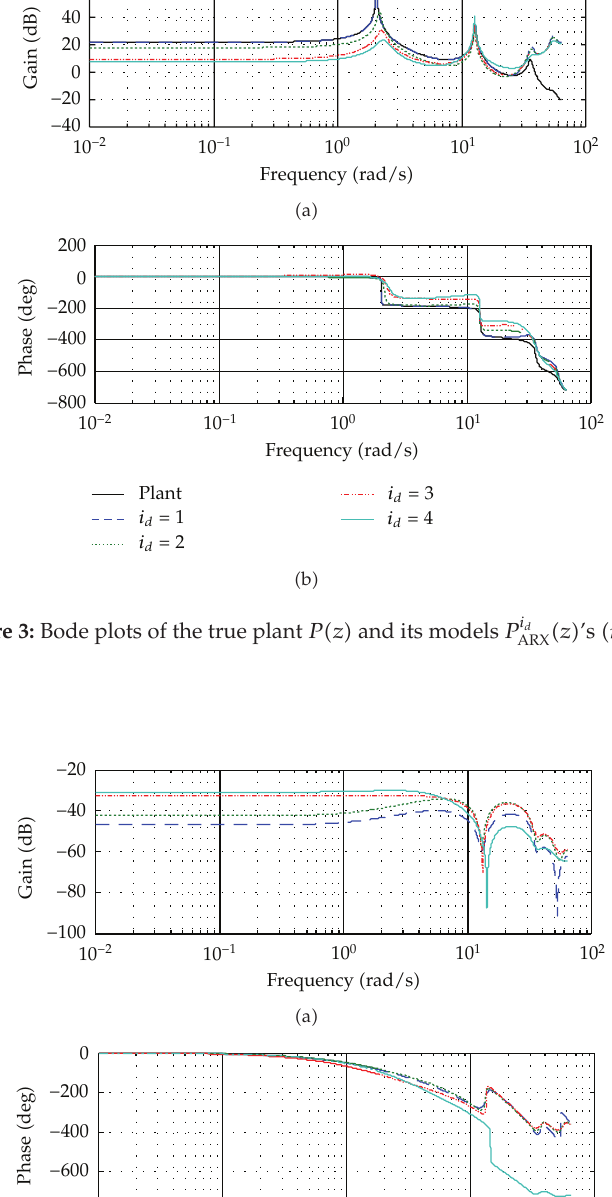
Figure 4: Bode plots of the the feedback controllers K i d (cid:4) z (cid:5) ’s (cid:4) n (cid:7) 8 (cid:5)